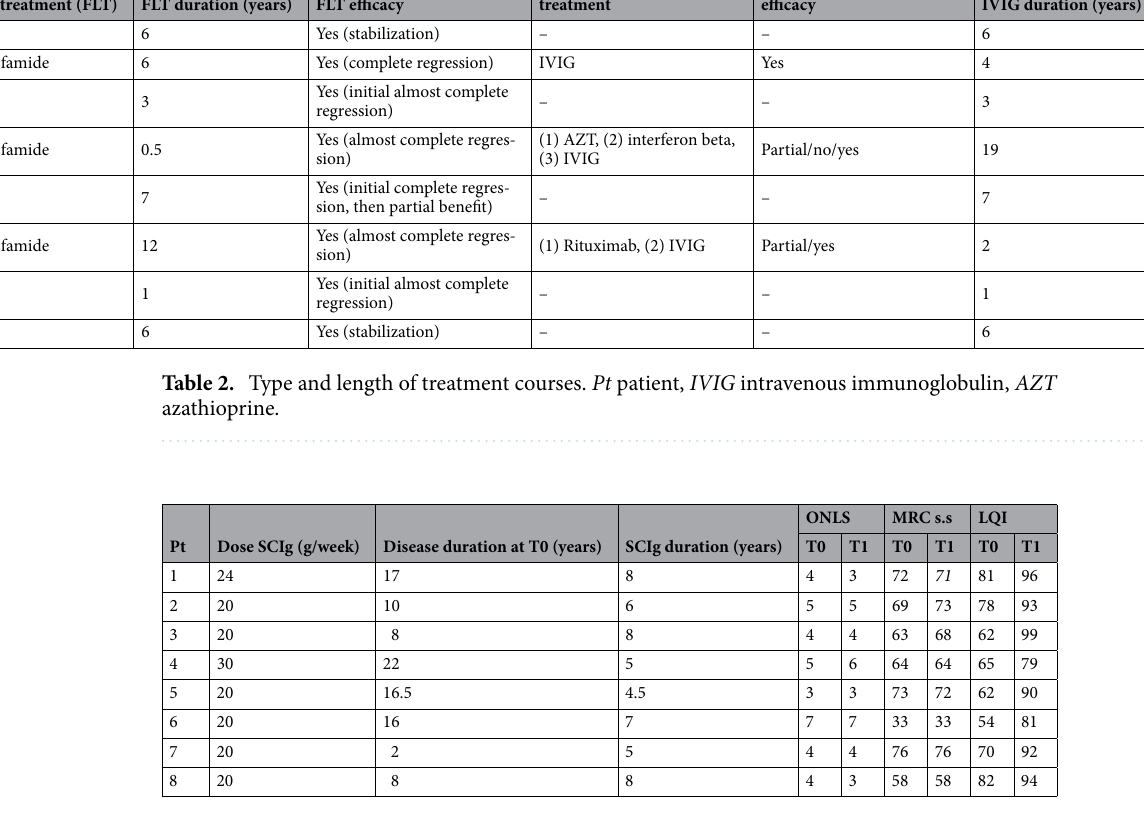
Table 3. SCIg administration results. Pt patient, ONLS overall neuropathy limitation scale, MRC s.s. medical research council sum score, LQI life quality index questionnaire, T0 baseline (at SCIg treatment beginning), T1 last